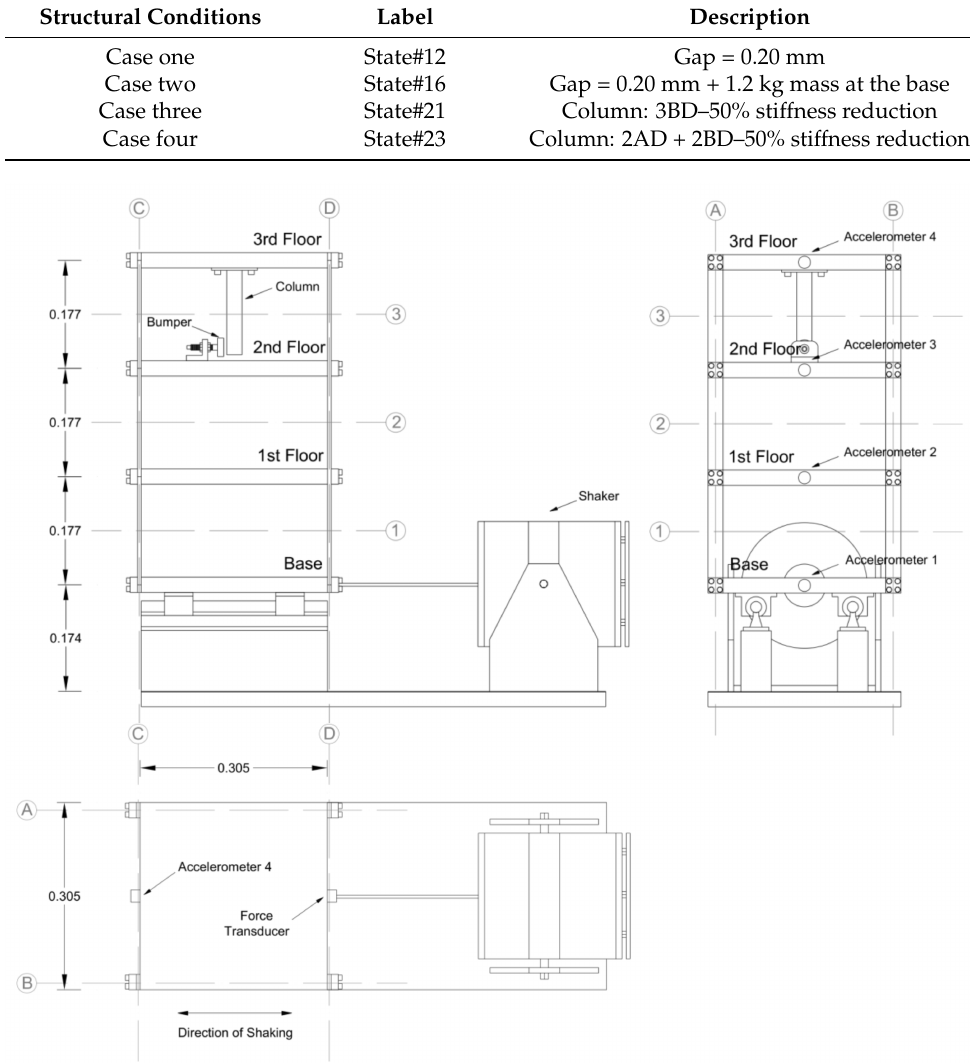
Figure 15. Dimensions information of the three-story building